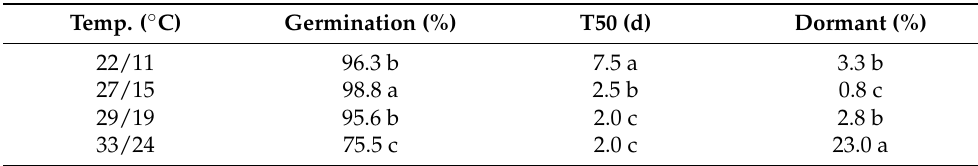
Figure 4. ( A ). Non-destructive X-ray analysis of Helianthus verticillatus seeds revealing presence (white) or absence (dark) of embryos. ( B ). Representative image of germinated (white-green, radicle emergence) seed. Table 2. Average final germination percentage and number of days to 50% of final germination (T50) of Helianthus verticillatus seeds collected from Maryville, Tennessee (USA) on 2 November 2017. Seeds were germinated with light (12 h photoperiod) in germination boxes placed in incubators set at 22/11, 27/15, 29/19, and 33/24 ◦ C for 28 days. Post-germination tetrazolium tests were conducted on all non-germinated seeds to determine percent dormancy (viability) 1